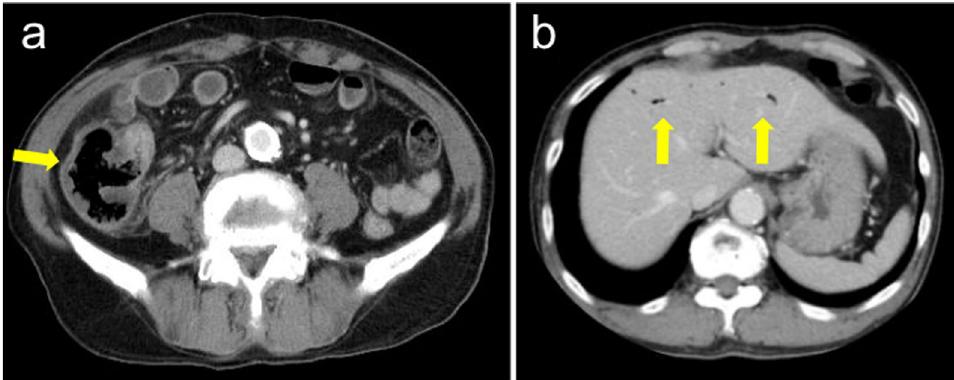
Fig. 1 Contrast-enhanced computed tomography. a Enhancement of the cecal wall is attenuated (arrow) and an increase in the surrounding fat tissue density is detected. b Intra-hepatic portal venous gas is observed (arrow)